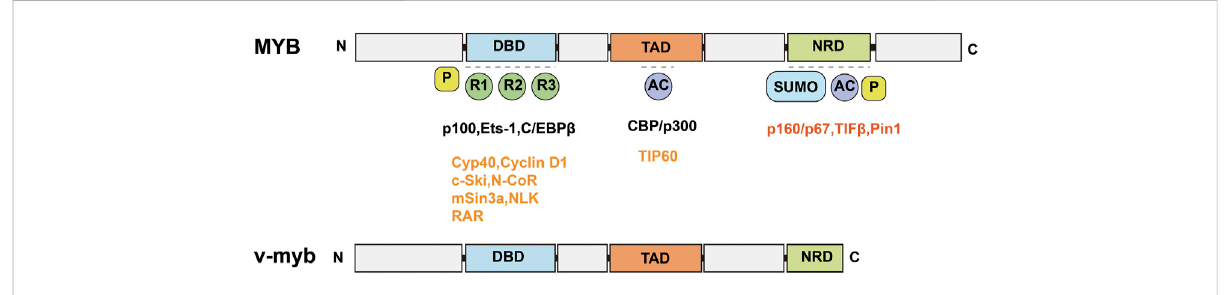
FIGURE 2 Schematic structure of MYB and v-myb. MYB consists of an N-terminal DNA binding domain (DBD), a C-terminal negative regulatory domain (NRD) and a central trans-activation domain (TAD). v-myb is derived from MYB